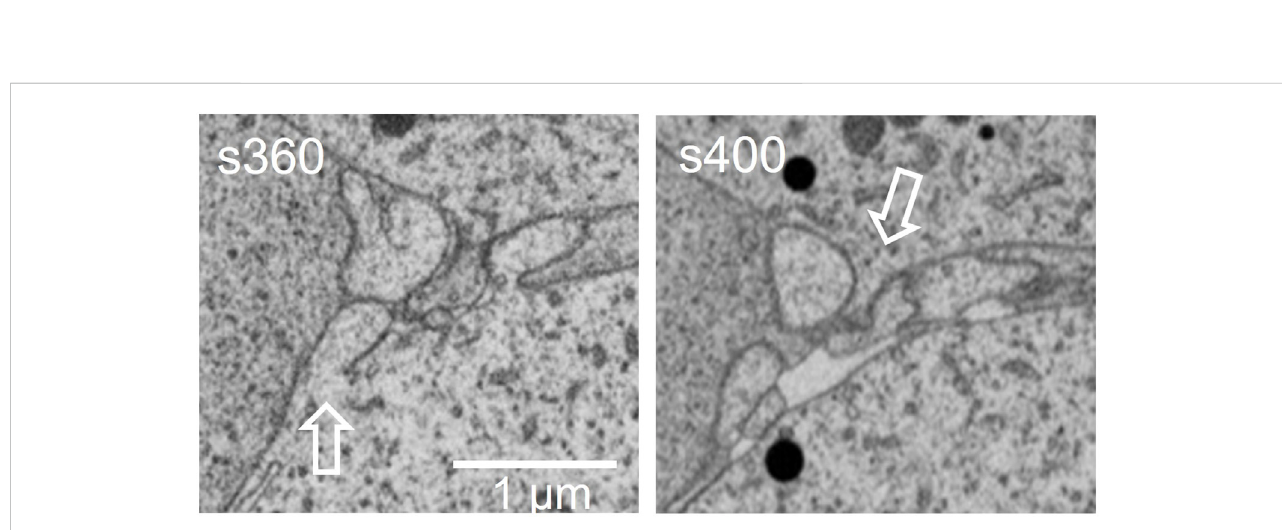
SEM of 2138 images, cropped and processed to show all images collected as a single volume image. This process was done using ORS Dragon fl y Software.